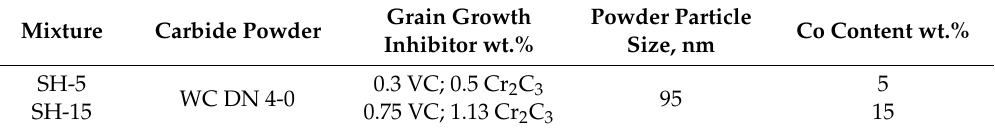
Table 2. Mixtures